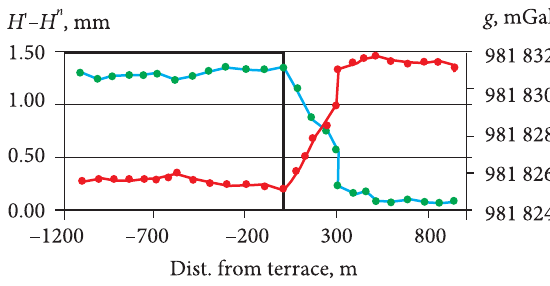
Fig. 6. Value of ' n H H − (blue line) and the observed gravity values g (red line) for the Tabasalu profile, an illustrative shape of the terrace (black line)